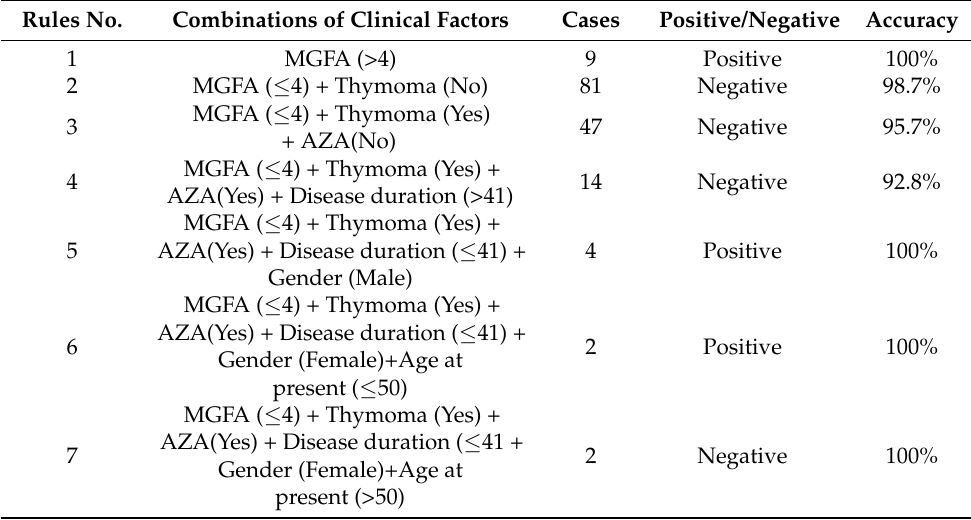
Table 5. Summarized decision rules of combinations of clinical factors. Rules